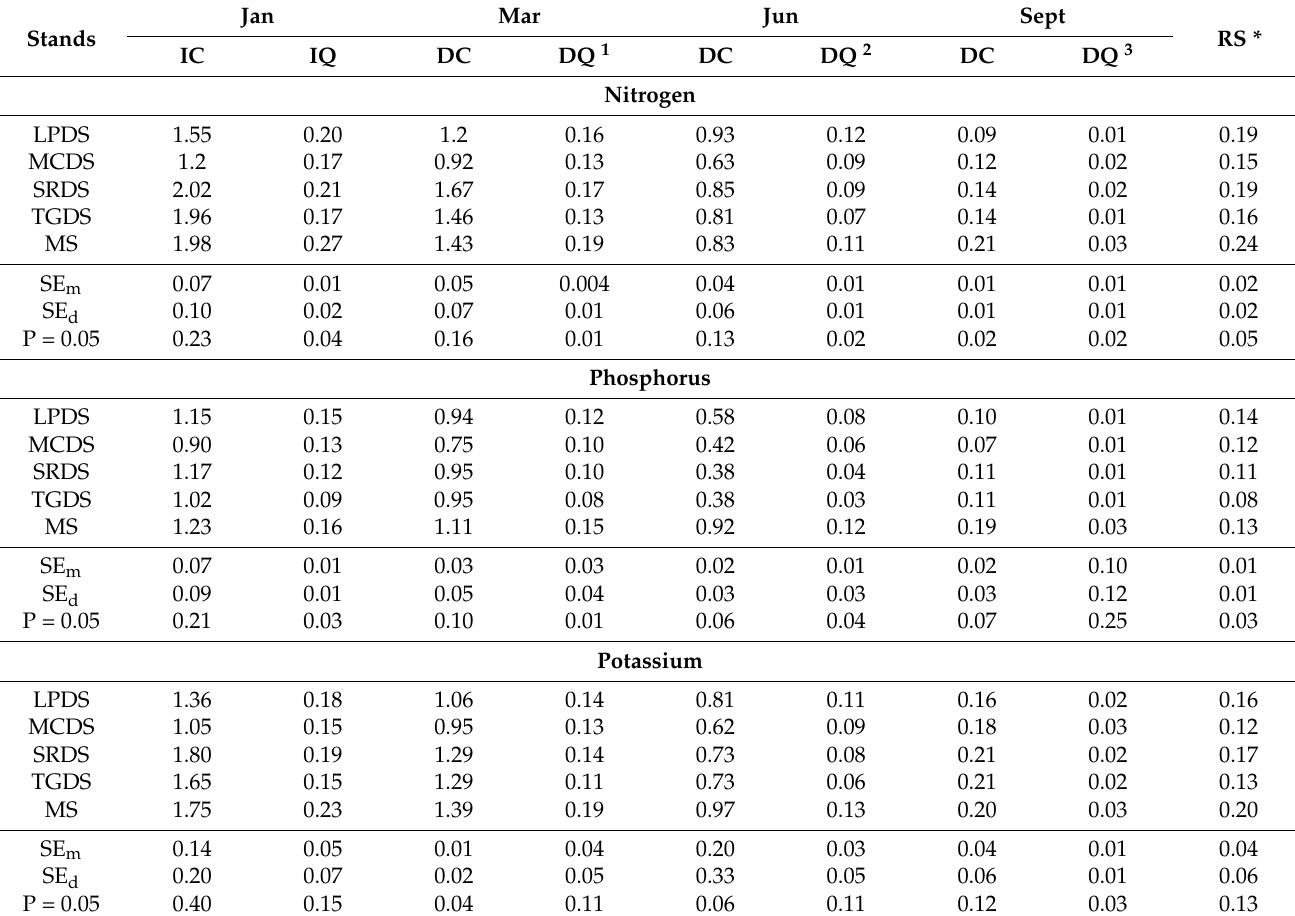
Table 3. Initial and periodic available ‘N’, ‘P and ‘K’ in litter of different stands during